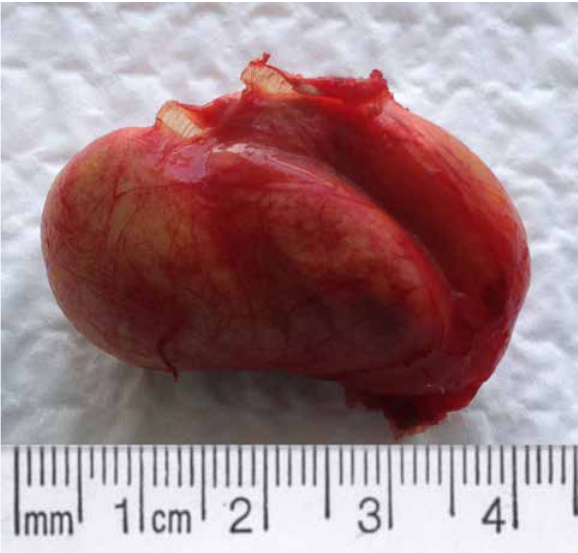
Figure 2: A 6-year old boy. A surgical specimen of the lesion in the left submental region